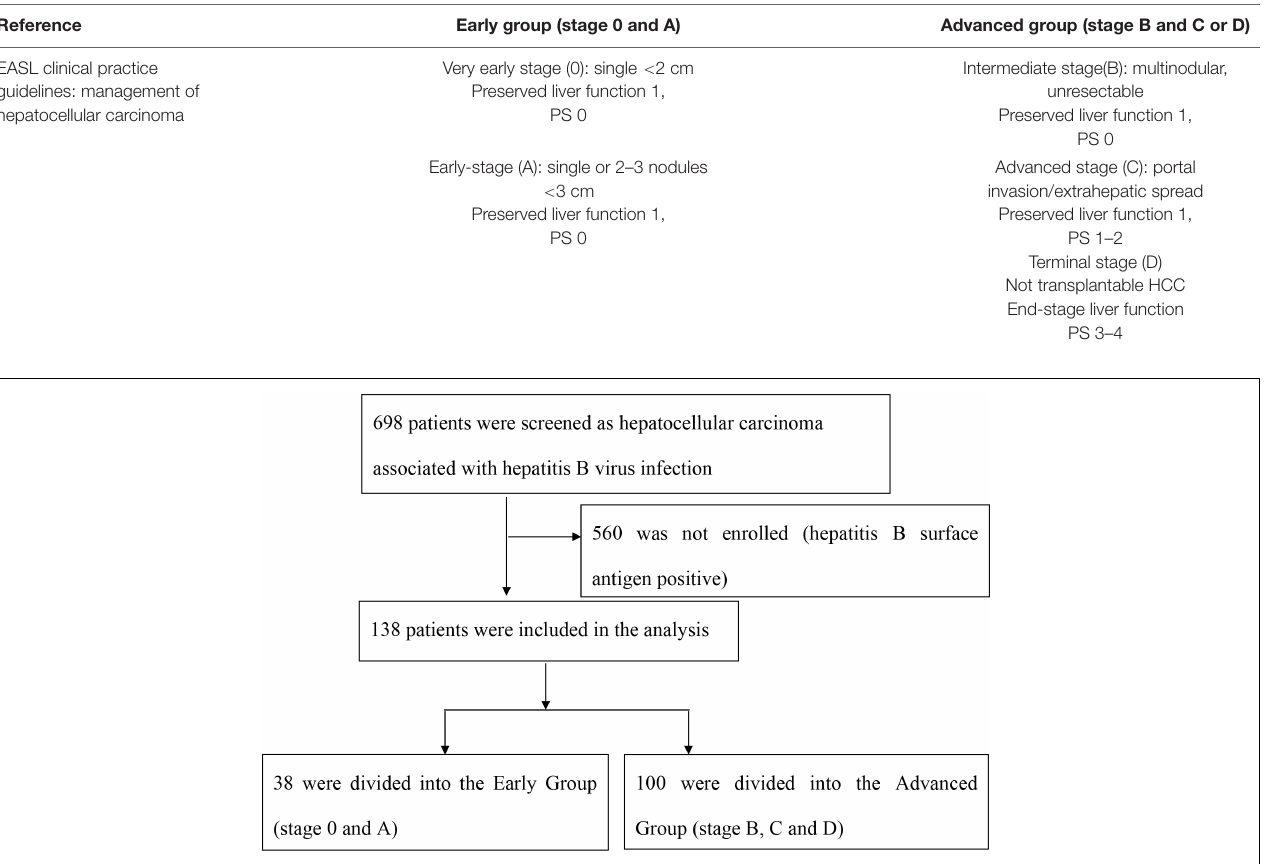
FIGURE 1 | The HCC stage grouping